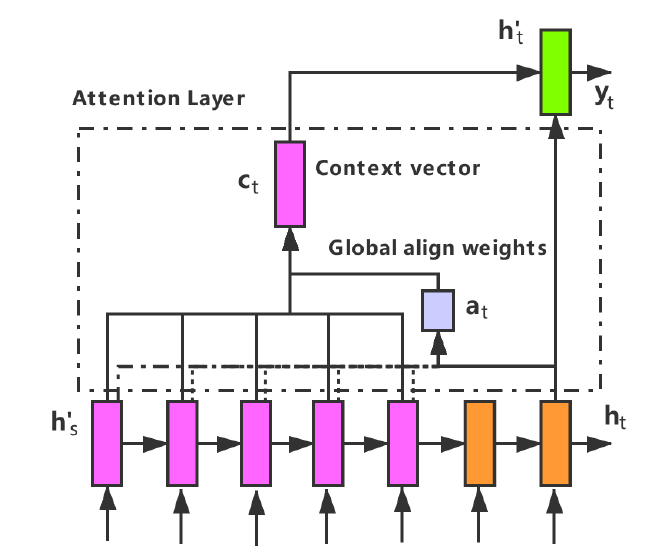
Figure 4. Basic principle of Attention